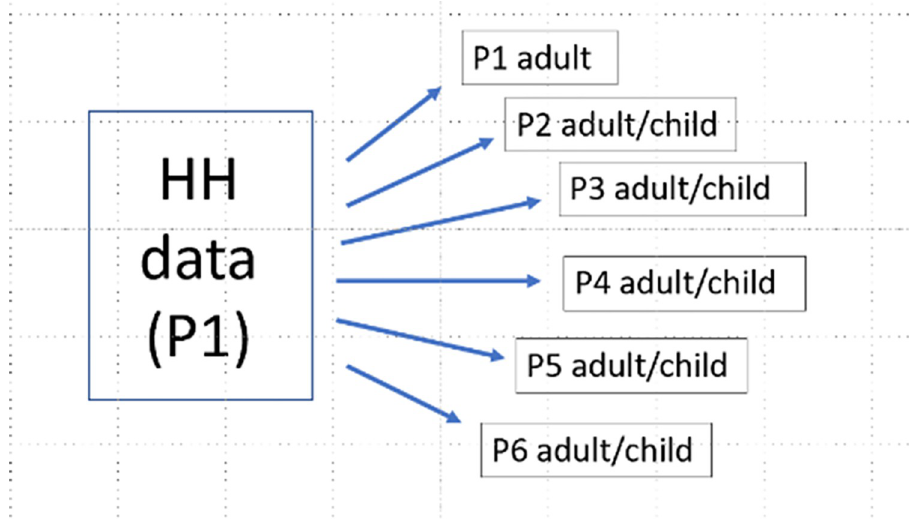
Fig 1. Database architecture, King County, WA COVID-19 antibody testing survey, August